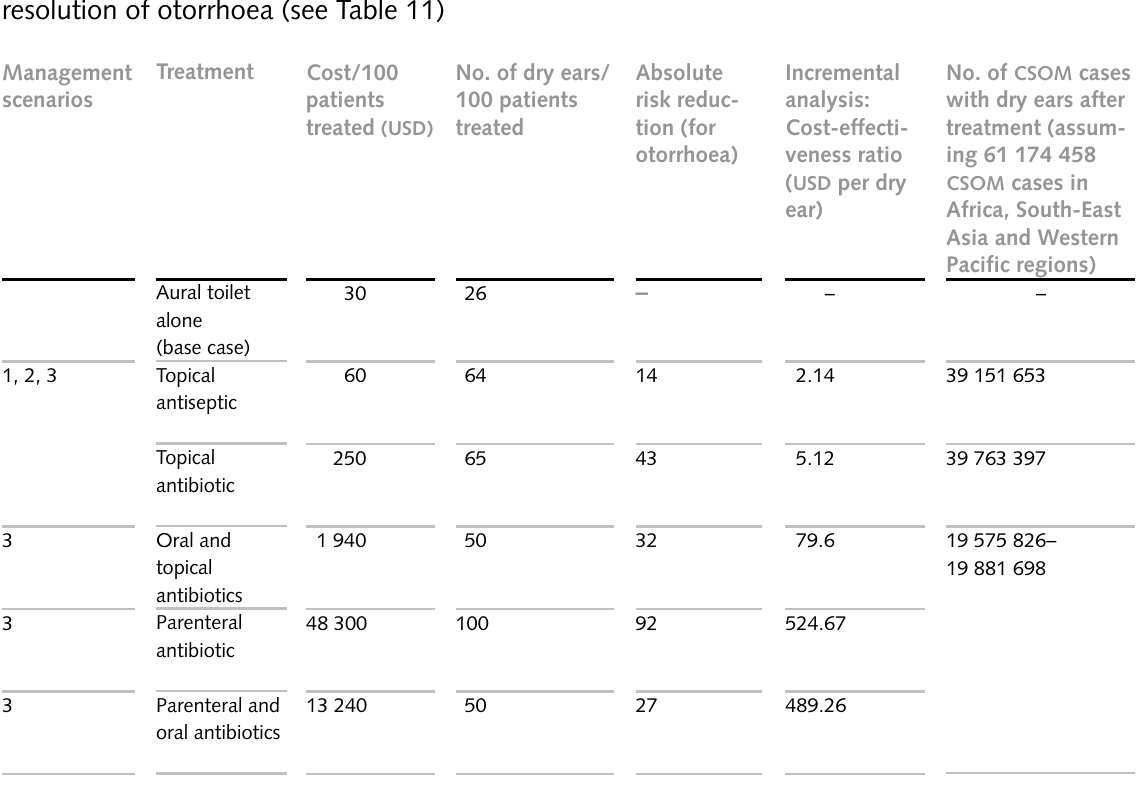
Table 17. Cost-effectiveness analysis of alternative treatments to ear wicking, in terms of resolution of otorrhoea (see Table 11)